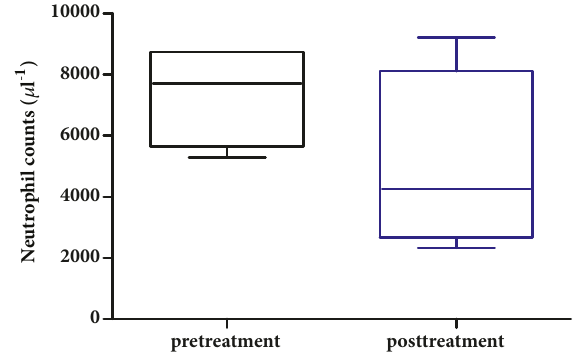
Figure 3: Neutrophil counts before and after chemotherapy treat- ments.Thepretreatmentresult included4 data points, eachof which was generated using a sample collected before each treatment. The posttreatment result also included 4 data points, each of which was generated using a sample collected after each treatment. Result indicatedthatneutrophil countsatpre-and posttreatmentswere not statistically different (p > 0.05, AVONA, GraphPad Prism).